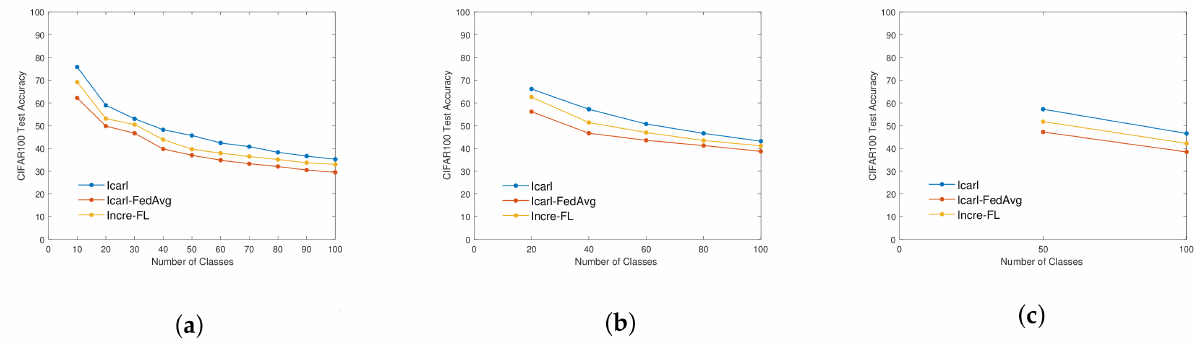
Figure 16. Cifar100 accuracy curve. ( a ) Accuracy graph when the class increment is 10. ( b ) Accuracy graph when the class increment is 20. ( c ) Accuracy graph when the class increment is